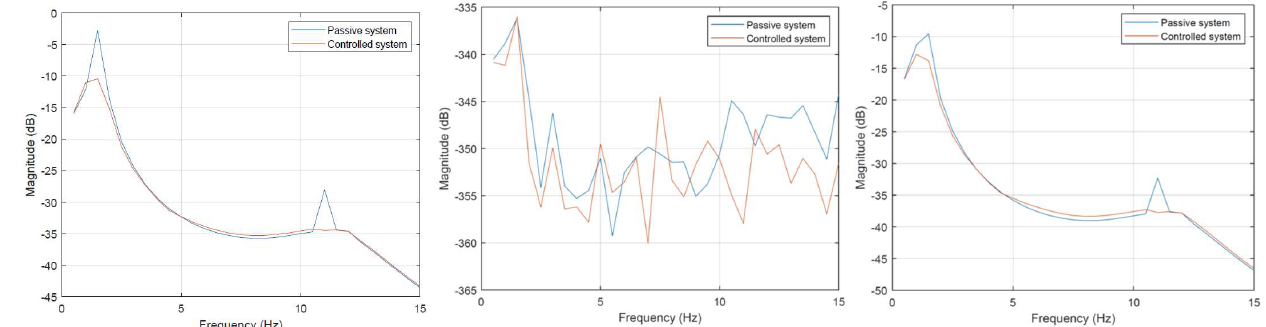
Figure 11. Vibration transmissibility characteristics for excitation of the front axis for both wheels simultaneously. Displacement of the center of mass—left characteristic, pitch angle—central characteristic, roll angle—right characteristic.